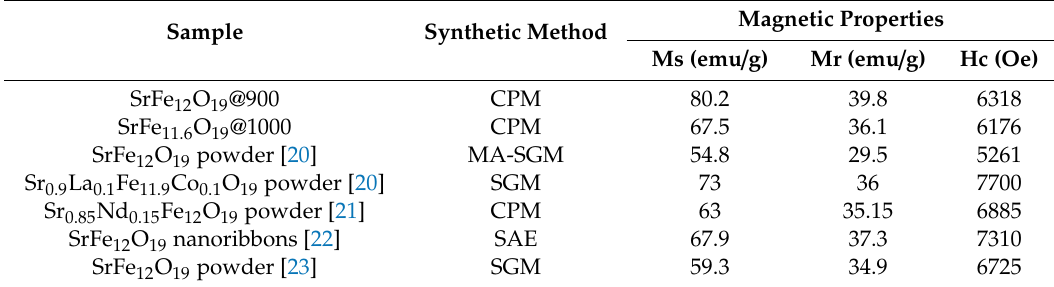
Table 4. Performance comparison between the samples obtained in this study and those reported in the